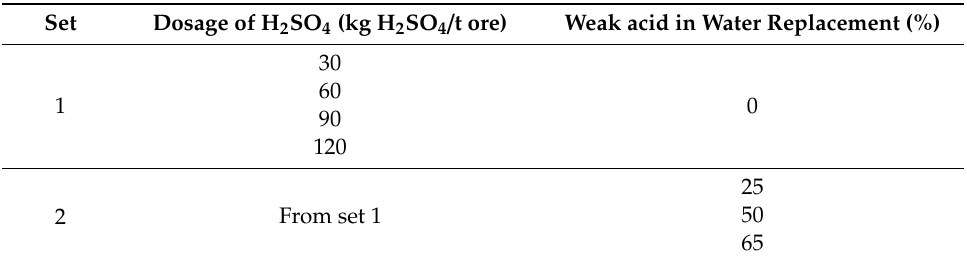
Table 4. Experimental design for curing tests.